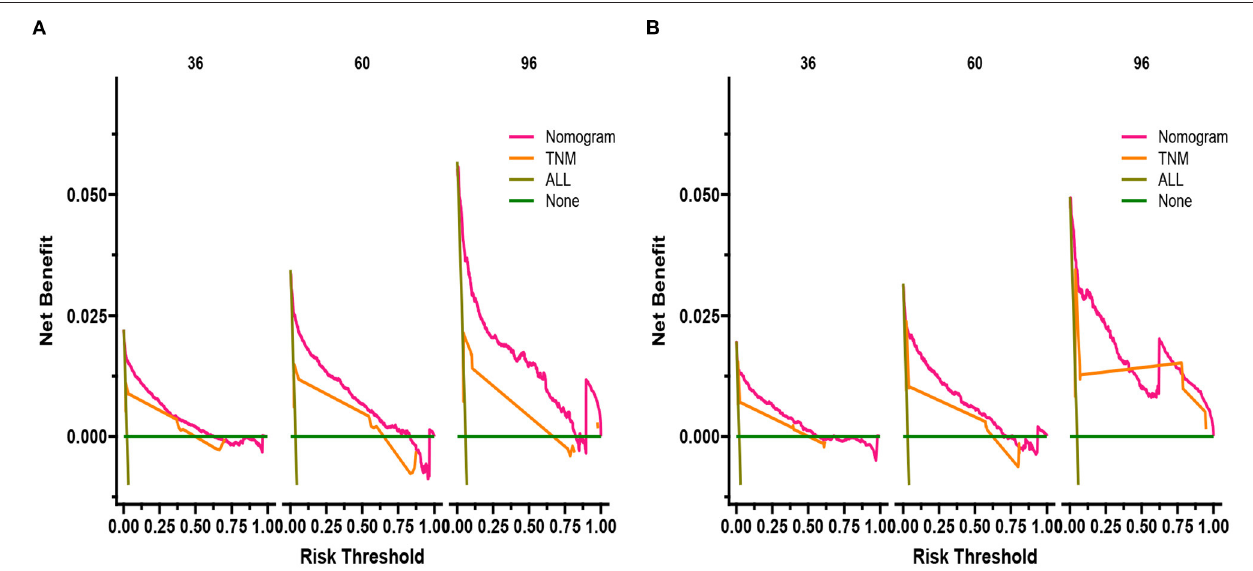
FIGURE 5 | DCA of the nomogram in the training set (A) and the validation set (B) . The Y-axis represents a net benefit, and the X-axis represents threshold probability. The green line means no patients died, and the dark green line means all patients died. When the threshold probability is between 0% and 100%, the net benefit of the model exceeds all deaths or none.